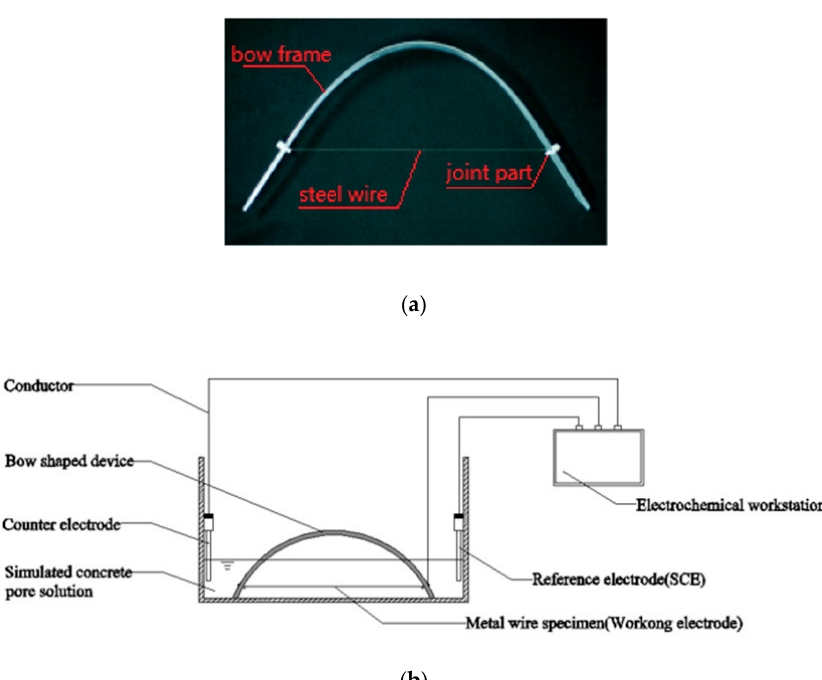
Figure 1. Illustration of corrosion test of steel wire in a corrosive solution. ( a ) Image and ( b ) schematic of corrosion test of steel wire in a corrosive solution.